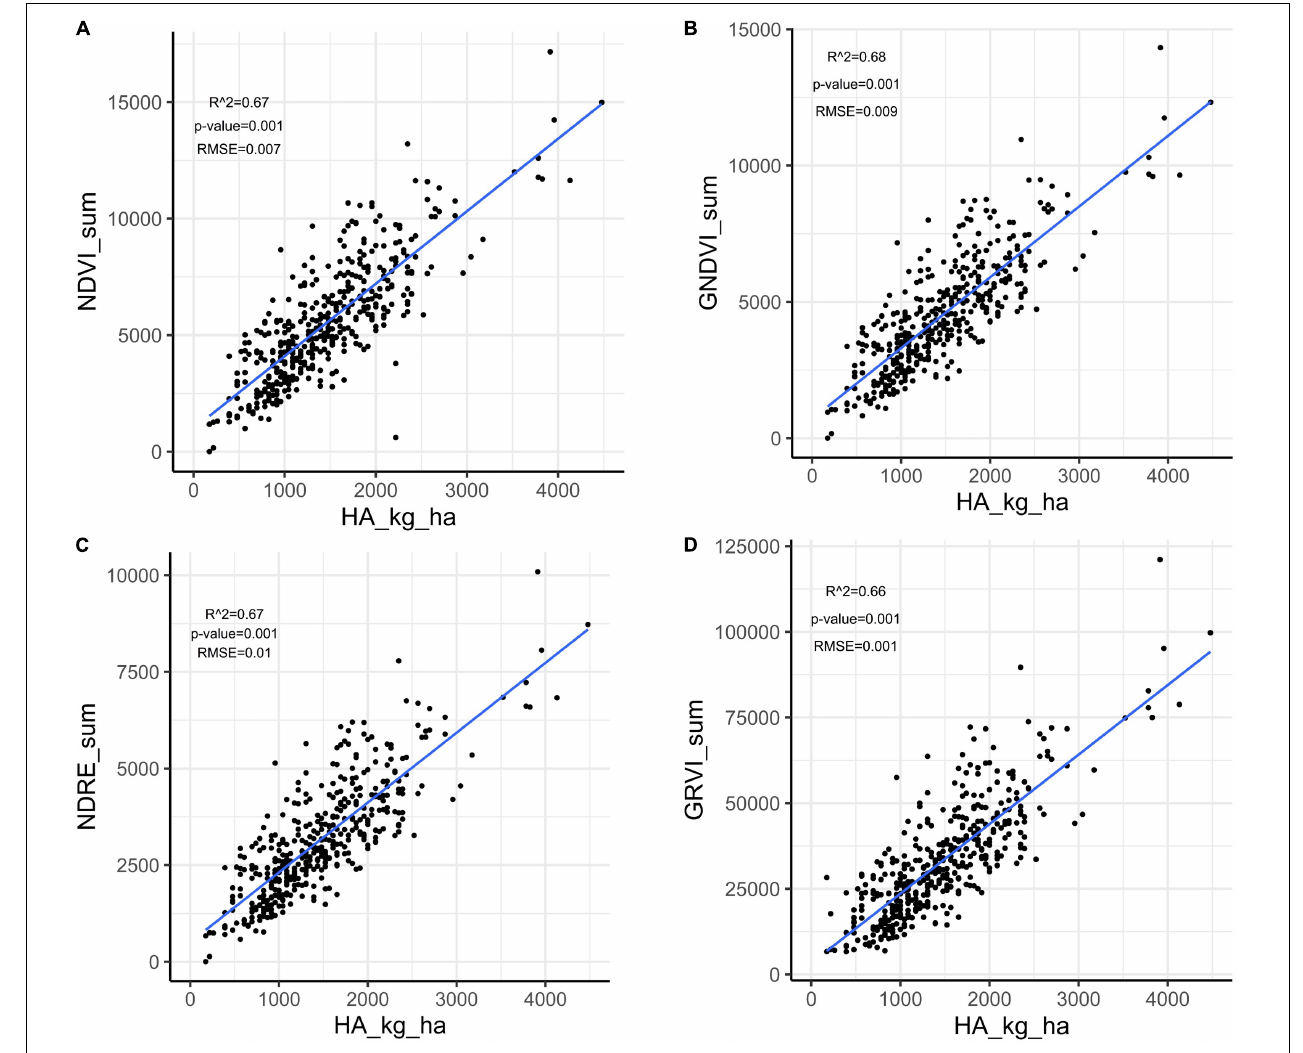
FIGURE 4 | Linear regression between herbage accumulation (HA_kg_ha) and unmanned aerial vehicles-based VIs collected in harvest one in alfalfa families evaluated in Citra, FL. VIs: (A) NDVI, normalized difference vegetation index; (B) GNDVI, green normalized difference vegetation index; (C) NDRE, normalized difference red edge; GRVI, (D) green and red ratio